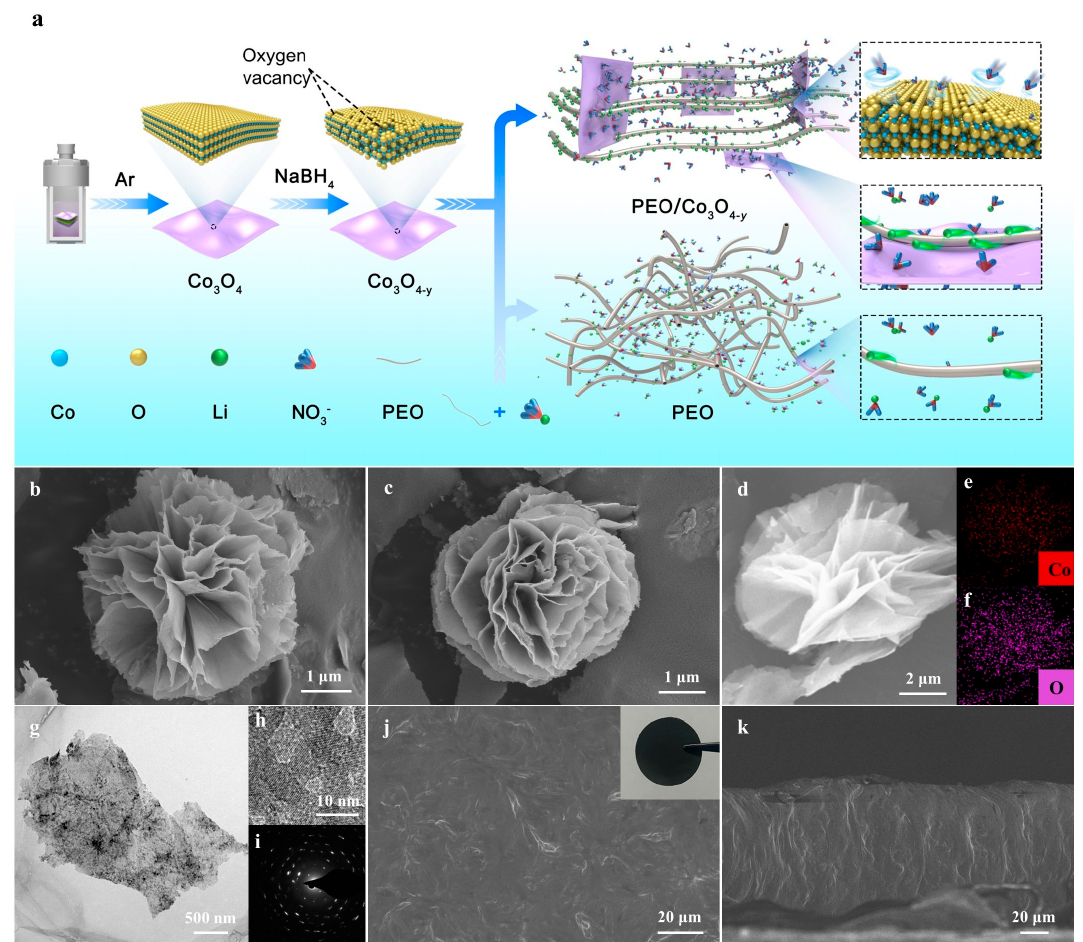
Figure 1. ( a ) Scheme of synthesis route of Co 3 O 4- y and its interaction with LiNO 3 additive and PEO chains. ( b ) Scanning electron microscopy (SEM) image of Co 3 O 4 . ( c – f ) SEM images of Co 3 O 4- y − 2 and its corresponding elemental mappings of ( e ) Co and ( f ) O. ( g , h ) TEM images and ( i ) SEAD pa tt en of Co 3 O 4- y − 2. ( j ) Top-view and ( k ) side-view SEM images of PEO/Co 3 O 4- y − 2 electrolyte fi lm.